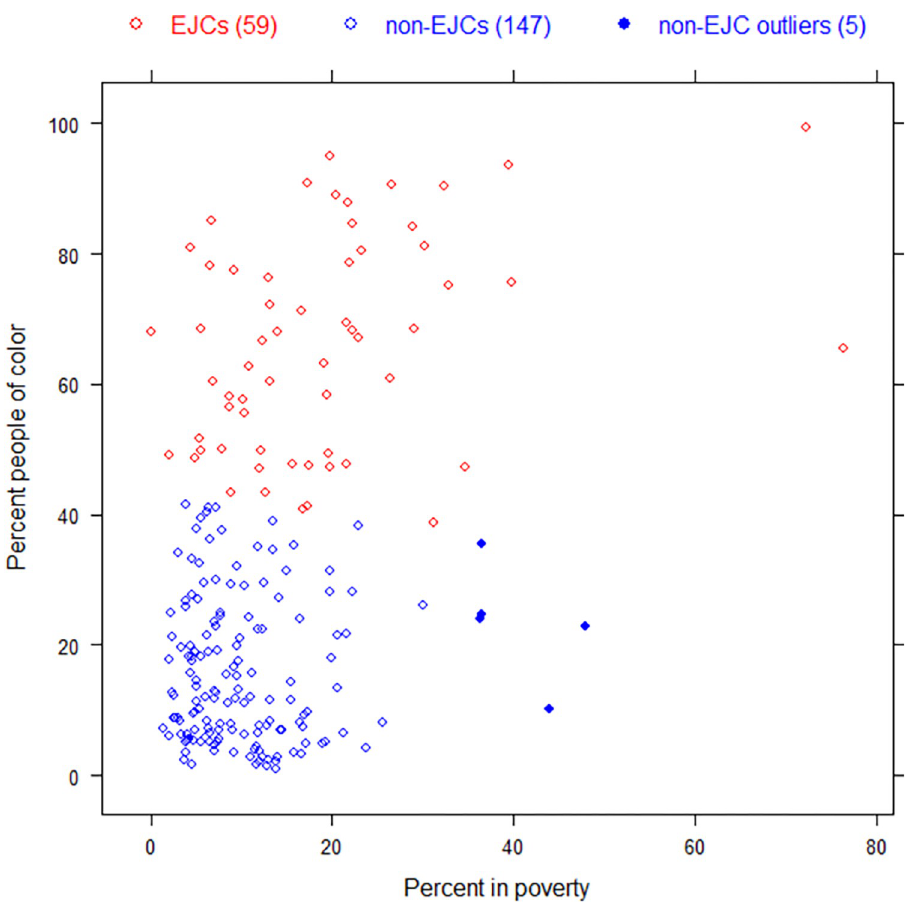
Fig 3. Percent people of color and percent in poverty statistics in k-means cluster analysis of census tracts hosting EGUs in RGGI.